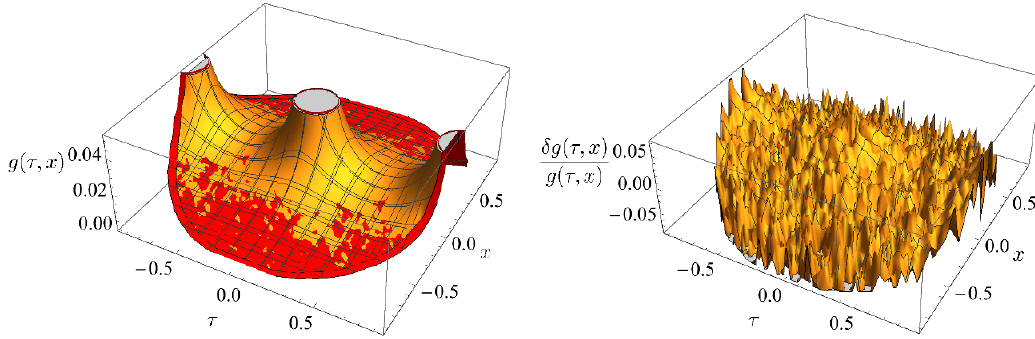
Figure 5. Left: the thermal two-point function obtained by applying the inversion formula and then solving the KMS condition (yellow) compared to that obtained from a MC simulation (red). Note that we restrict the plot to the region of OPE convergence around x = 0 and (cid:28) = 0. Right: percentage di(cid:11)erence between the two correlators, showing good agreement (within 5%) between p the bootstrap and MC predictions. At small values of j x j 2 + (cid:28) 2 we expect the MC results to be p inaccurate due to lattice-size e(cid:11)ects. As j x j 2 + (cid:28) 2 ! (cid:12) , we exit the region of OPE convergence, and we expect inaccuracies in the bootstrap